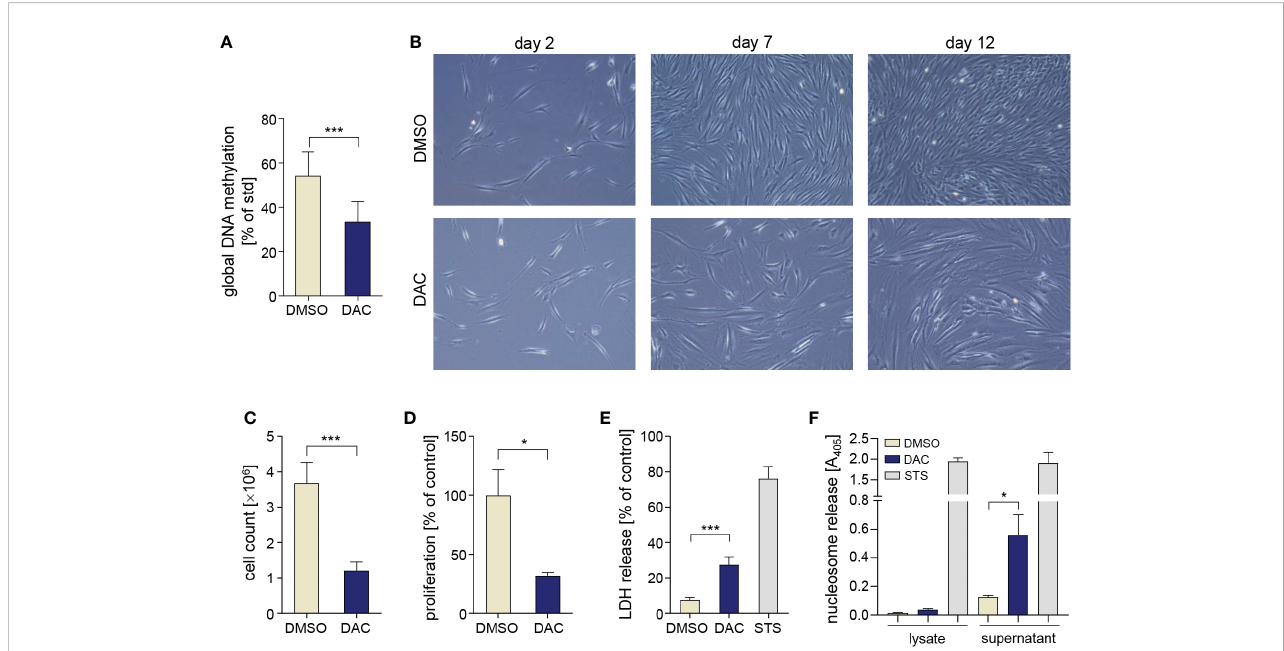
FIGURE 1 DAC induces global DNA hypomethylation and has anti-proliferative and cytotoxic effects on GFs. (A) Global DNA methylation in GFs cultured with DMSO or DAC for 12 days. (B) Representative micrographs of GFs cultured in the presence of DMSO or DAC for 12 days. Pictures were taken on days 2, 7, and 12 of the experiment using contrast-phase microscopy. (C) GF total cell counts (n=4) and (D) proliferation rate determined using the BrdU incorporation assay (n=8) after 12 days of culture with DMSO or DAC. Viability of GFs treated with DMSO or DAC for 12 days measured using (E) the LDH release assay (n=7) and (F) analysis of nucleosome release into cytosolic cell fractions (n=3) and culture supernatants (n=4). GFs treated with 1 µM staurosporine (STS) were used as a positive control. *P < 0.05, ***P <